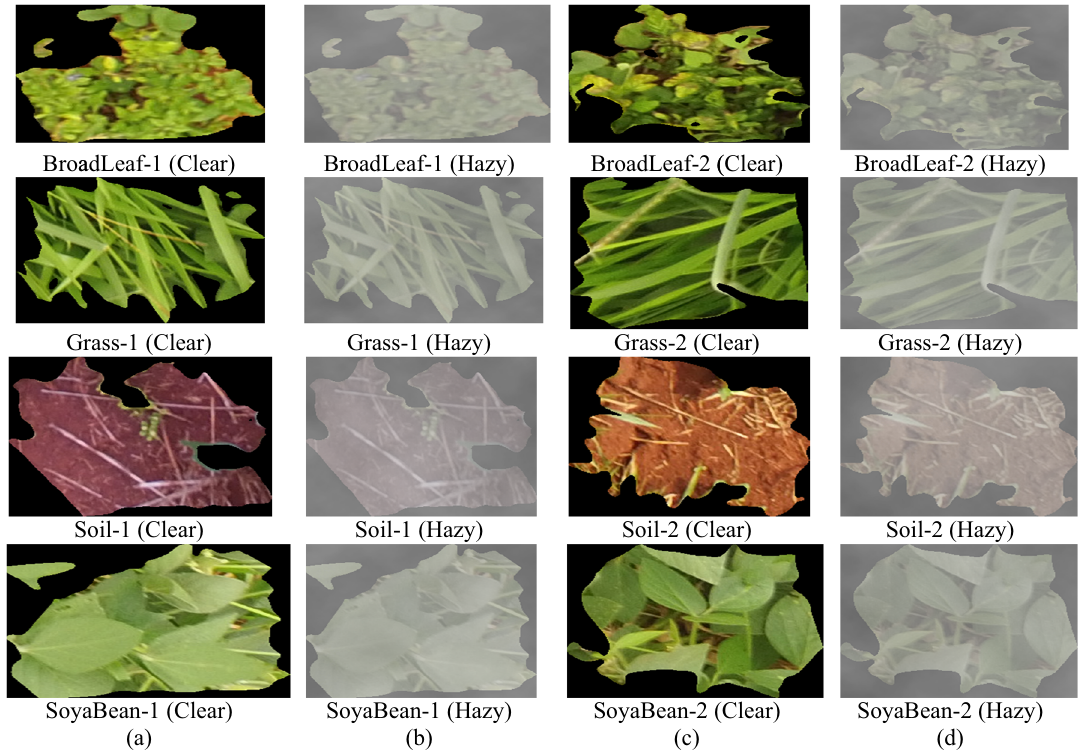
Figure 4: ( a and c ) Clear images of broadleaf, grass, soil, and soyabean; ( b and d ) hazy images corresponding to images shown in ( a and c )